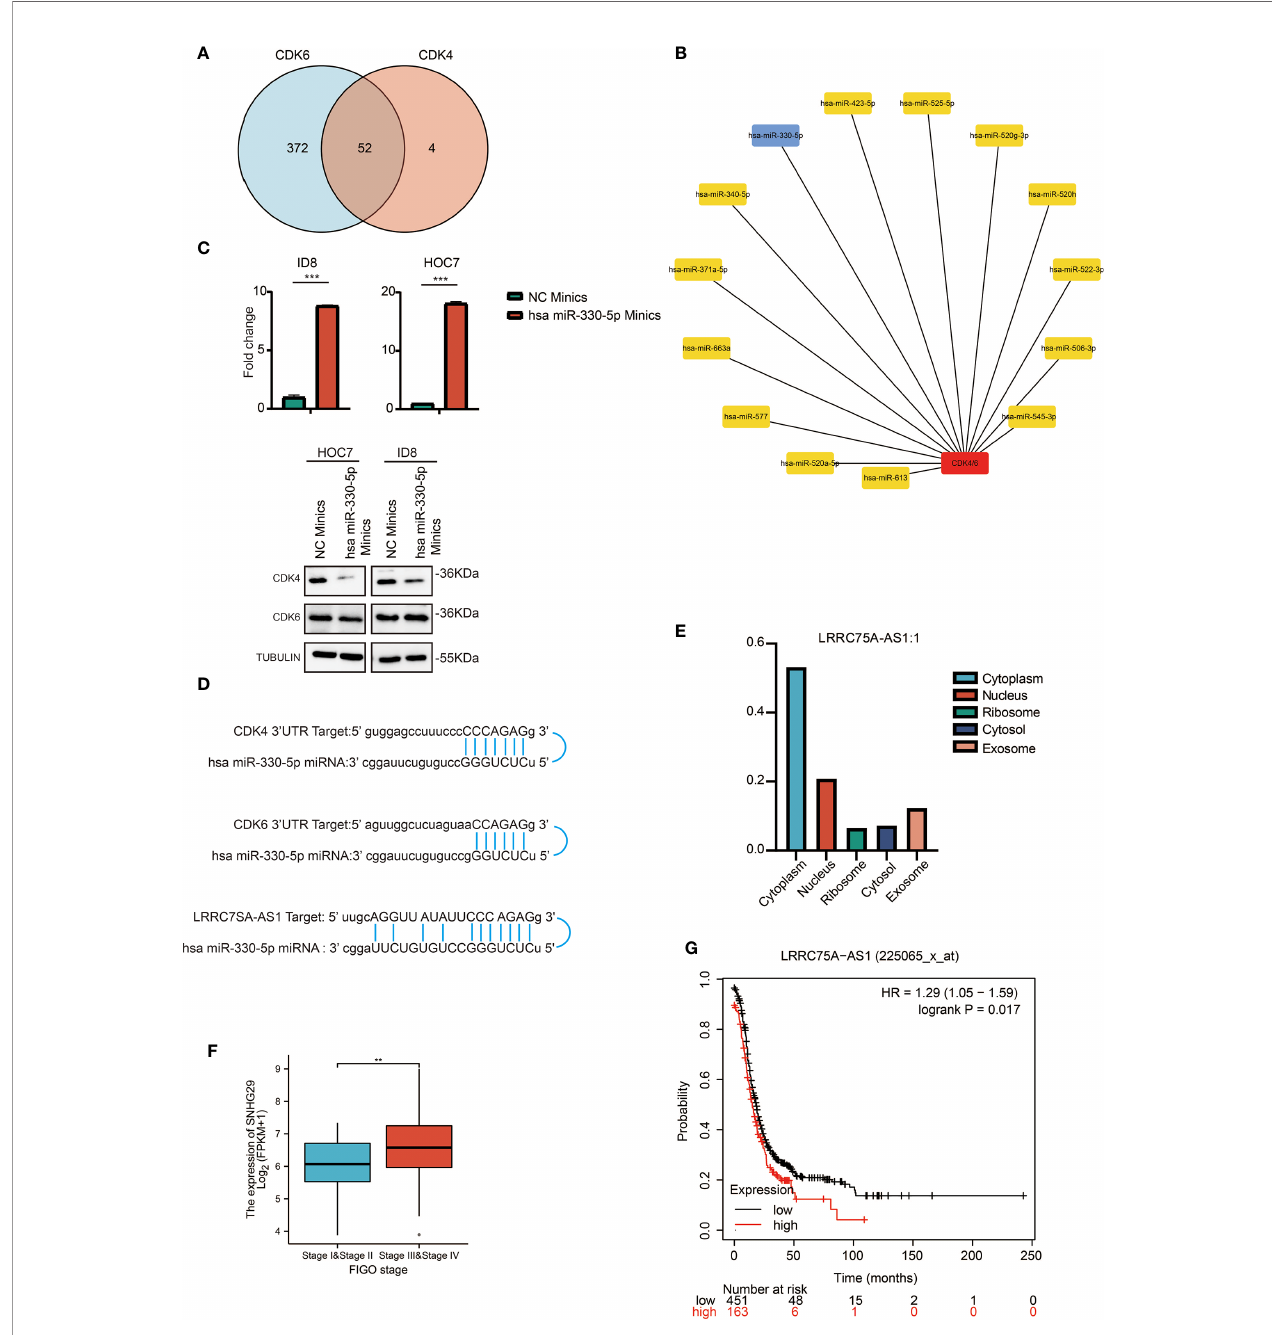
FIGURE 4 | Prediction and analysis of upstream lncRNAs and miRNAs of CDK4/6. (A) Venn diagram showing the intersection of miRNAs targeting CDK4 and CDK6. (B) A signi fi cant miRNA-CDK4/6 regulatory network established by cytoHubba plug-in of cytoscape software. (C) QRT-PCR analysis of has miR-330-5p in ID8 and HOC7 treated with NC mimics and has miR-330-5p mimics for 72 h (upper). The p values were calculated using the Student t-test: ***P < 0.001. Western immunoblotting demonstrating expression level of CDK4/6 in ID8 and HOC7 treated with NC mimics and has miR-330-5p mimics for 72 h (lower). (D) Schematic diagram showing the regulatory relationship between ncRNAs and CDK4/6. (E) Bar graph showing the subcellular localization of LRRC75A-AS1. (F) Comparison of LRRC75A-AS1 expression between stages I & II and stages II & IV in the OC TCGA cohort. **p-value <0.01; ***p-value <0.001. (G) Kaplan – Meier analysis of the association between LRRC75A-AS1 expression and OS in OC. P values in (F) shows that there is a statistically signi fi cant difference in the expression level of LRRC75A (SNHG29) between the I/II and III/IV stages of ovarian cancer in the ovarian cancer TCGA